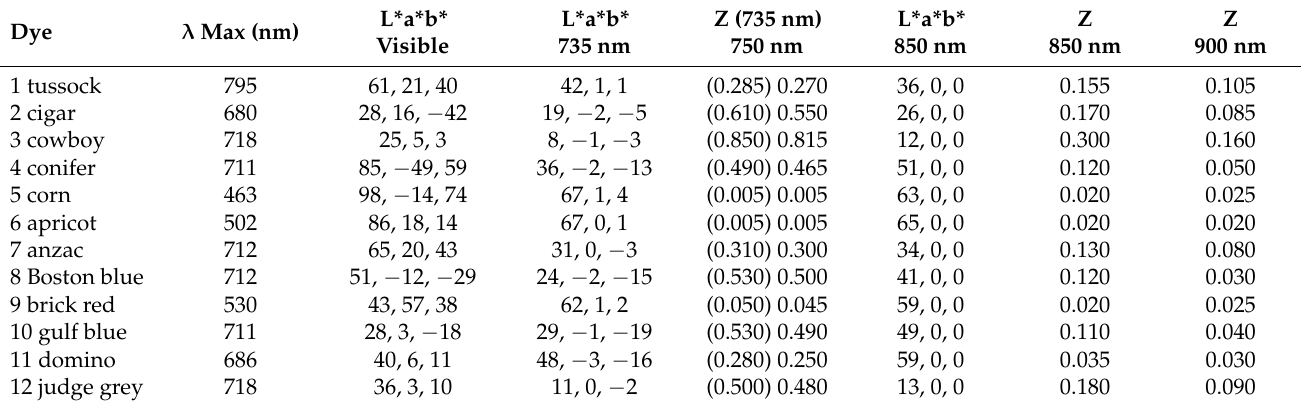
Table 1. ACR11 dyes (1–12), λ max, Lab V, Lab 735, Lab 850, Z (735)750, Z 850, Z